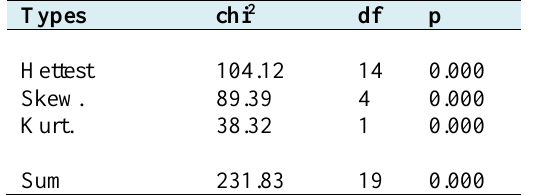
Table 5. Cameron & Trivedi's breakdown of IM-experiment